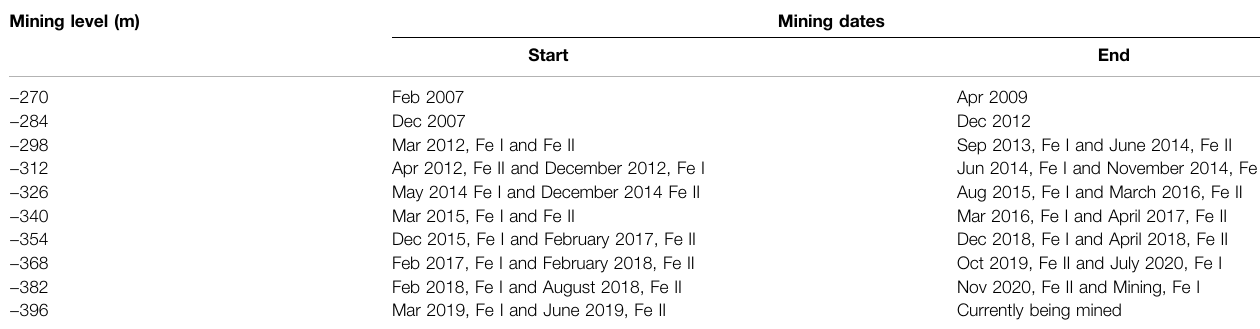
TABLE 3 | Mining situation. Mining level